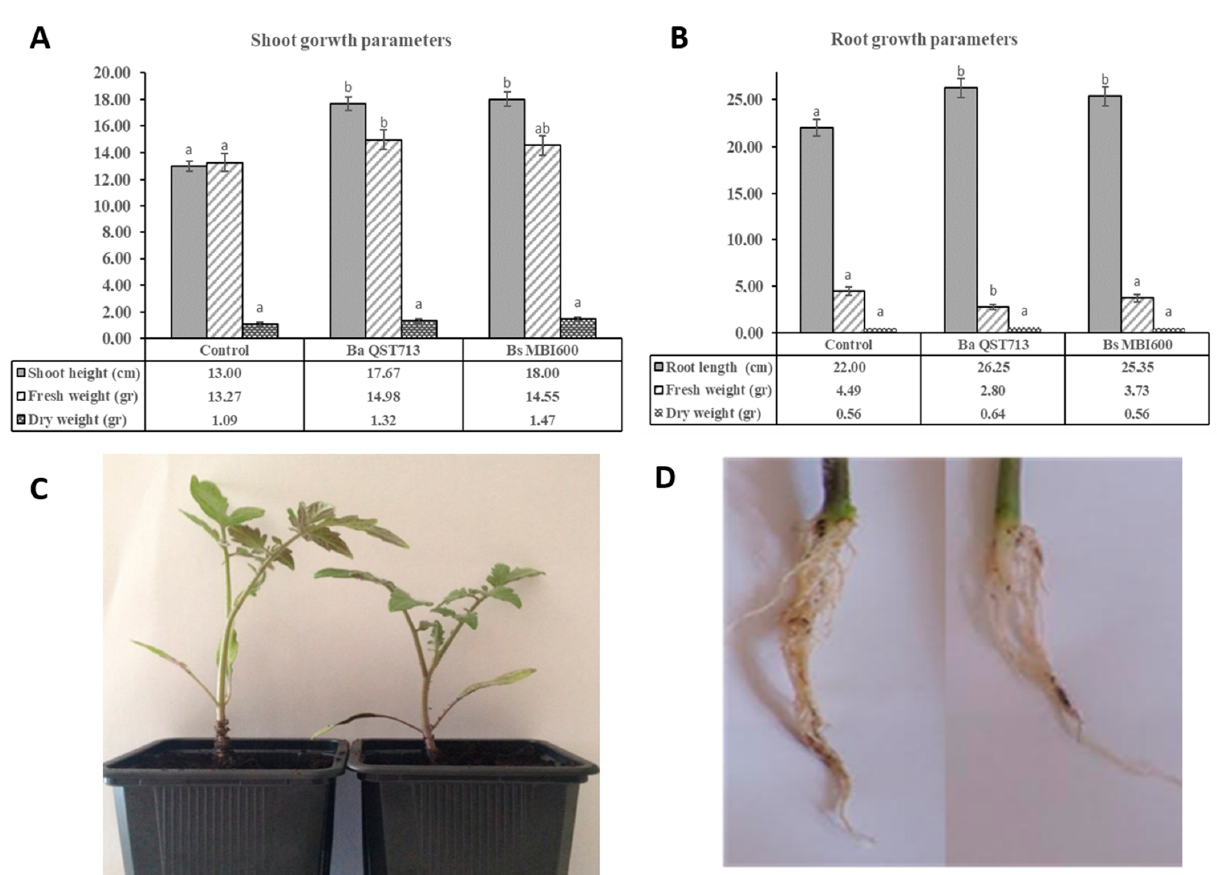
Figure 1. Effects of Bacillus subtilis MBI600 applications on tomato plant (cv. Belladonna) shoot ( A ) and root ( B ) growth parameters compared to the growth of untreated control plants and Bacillus amyloliquefaciens QST713-treated plants (reference biological treatment). Different letters in the columns indicate significant differences between the treatments according to Fisher’s LSD test ( p < 0.05). Vertical lines indicate the standard error of the mean. ( C ) Bs MB 600-treated (left side) and untreated plants (right side), showing differences in shoot lengths. ( D ) Bs MBI600-treated (left side) and untreated plants (right side), showing differences in root lengths.